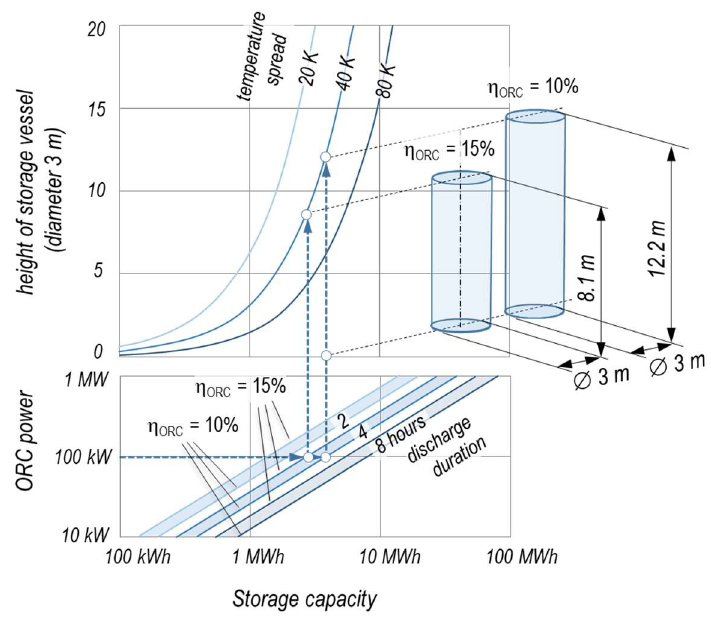
Figure 4. Required hot water storage volume with respect to the ORC power ( η ORC = 10% and 15%) and the temperature spread ∆ T of the hot water cycle.